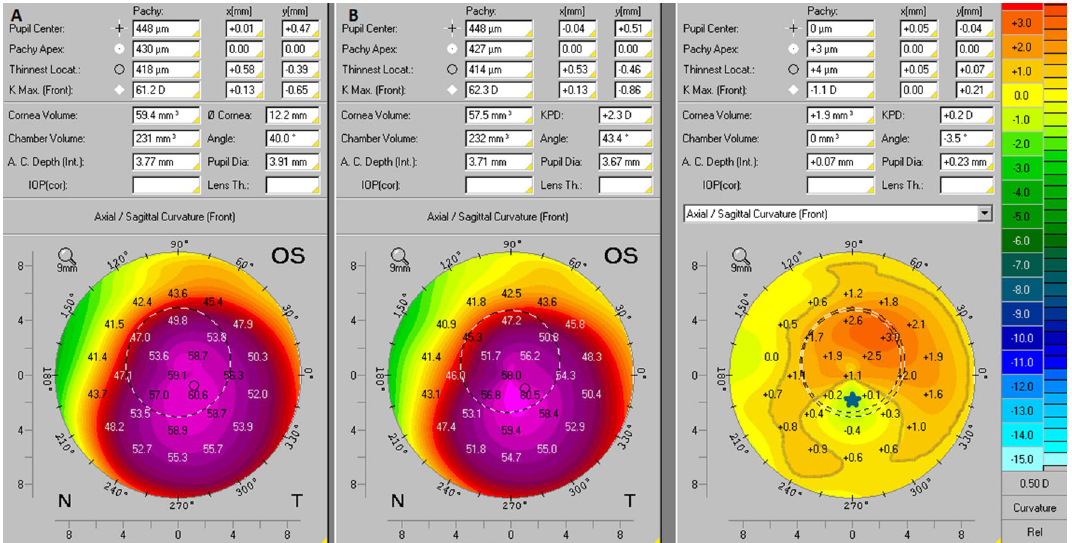
Figure 1. Anterior axial/sagittal curvature comparative maps of Pentacam HR images. In this case, the axial/ sagittal curvature maps had an interval of 12 months. In the initial exam ( B ) the Kmax was 62.3D and in the subsequent exam ( A ) the Kmax was 61.2D, so there was no progression in this variable (blue star). On the other way, the comparative map showed an increase of more than 1D in the anterior curvature of the non-apical corneal zone which was highlighted by the gray line, thus showing KCE